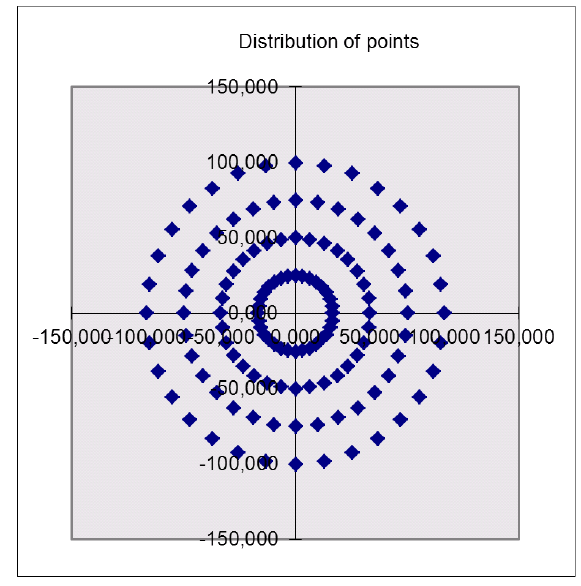
Figure 7. Scheme of the points location in the simulated